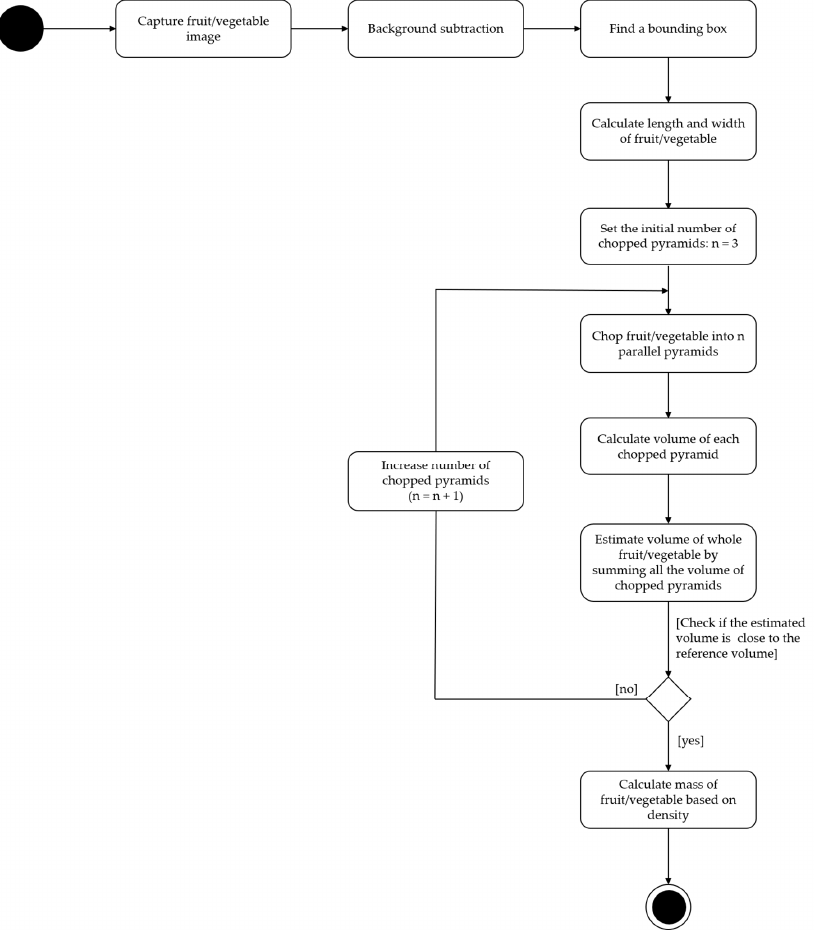
Figure 7. The activity diagram of the proposed system.